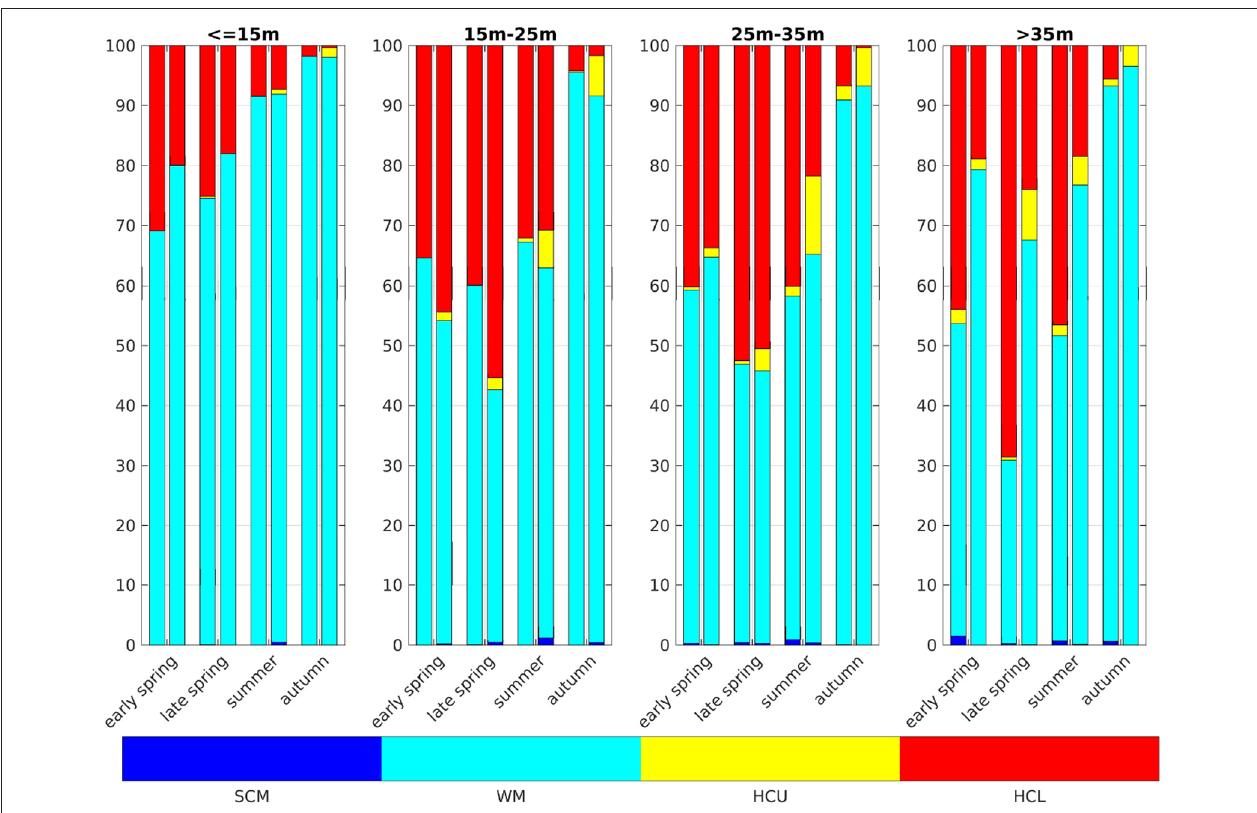
FIGURE 10 | Categories of vertical chlorophyll profiles in the German Bight. Dark blue are subsurface chlorophyll maxima (SCM), turquois are well mixed profiles (WM), yellow are high chlorophyll content in upper layers (HCU), and red are high chlorophyll content in lower layers (HCL). The left bars show the classic scheme and the right the IND. Early spring is March and April, late spring is May, summer is June, July, and August, and autumn is September, following the classification of Zhao et al. (2019b)